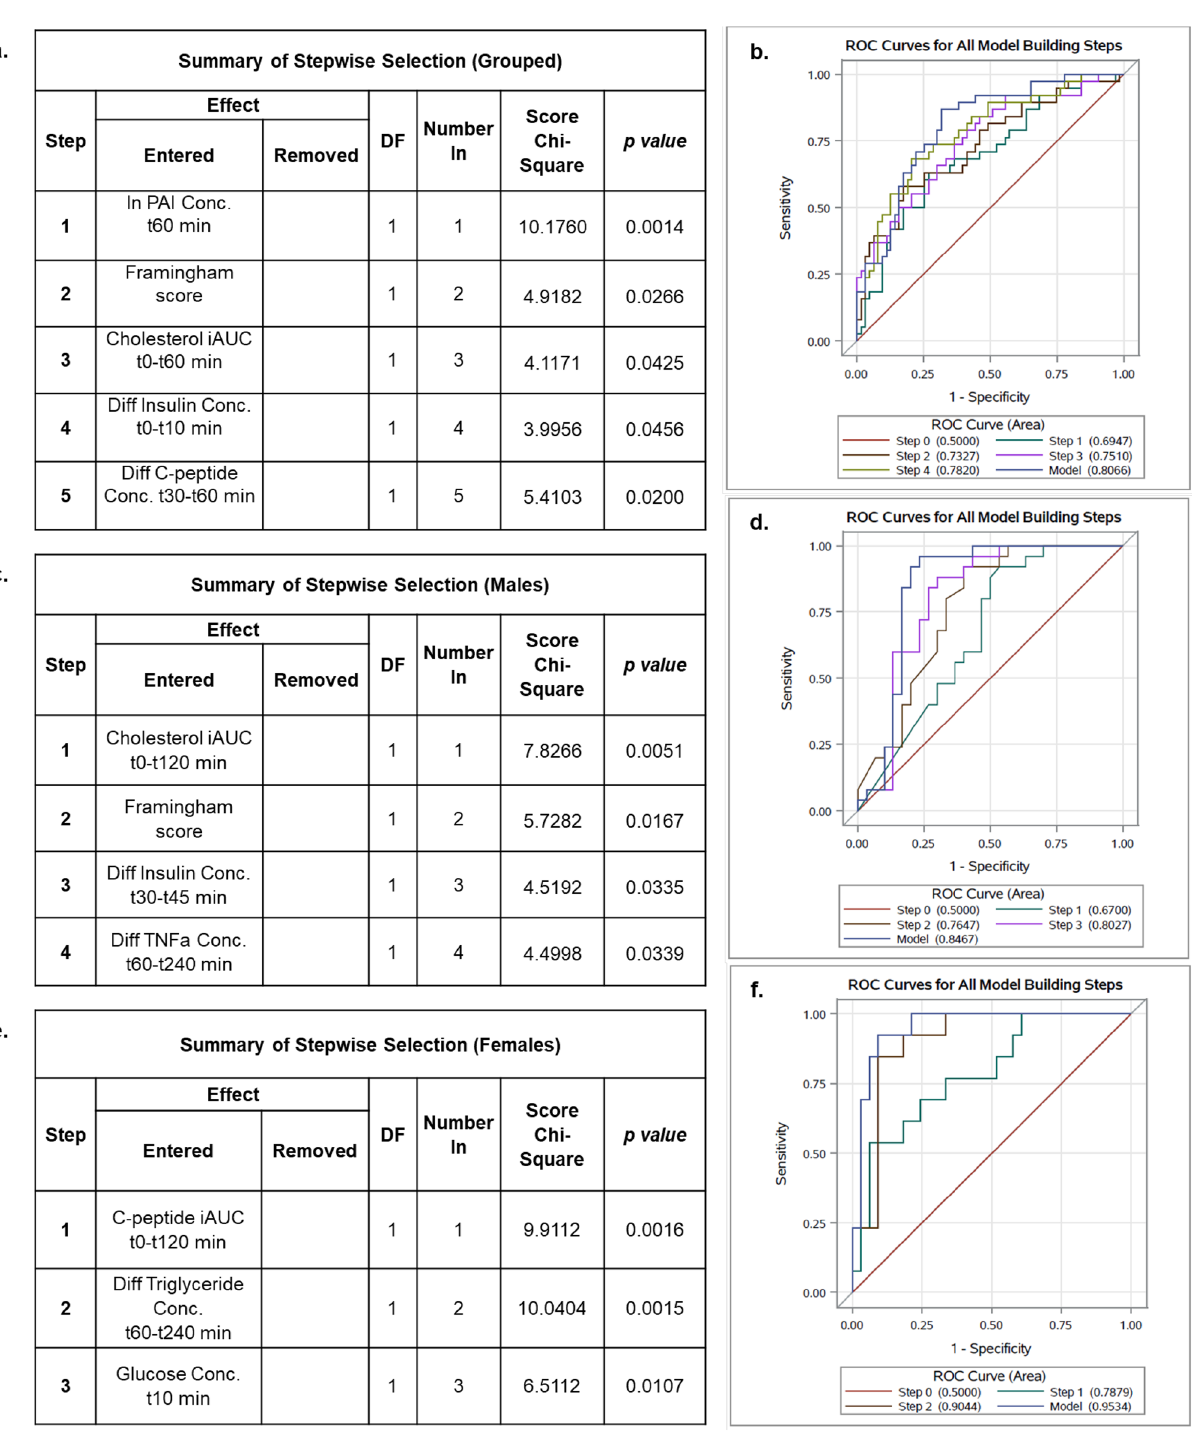
Figure 2. Summary of sequential entrance of variables into multivariable model and incremental improvements to prediction accuracy of subclinical atherosclerosis, reflected by the area under curve of ROC curve in the grouped analysis ( a , b ), in males ( c , d ) and females ( e , f ). TNFa, Tumor necrosis factor alpha; iAUC, incremental area under curve; PAI-1, Plasminogen activator